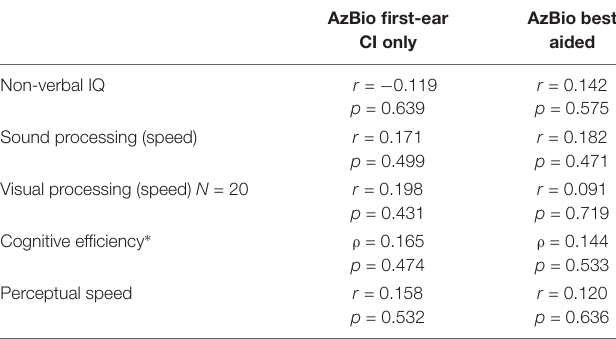
TABLE 4 | Correlations between AzBio speech scores (controlled for age), non-verbal IQ, and cognitive cluster